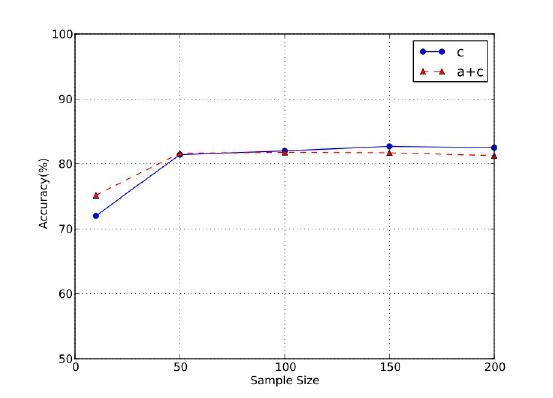
Figure 5. The accuracy using the Random Forest algorithm when varying the sample size. Note the y-axis does not start at 0 .